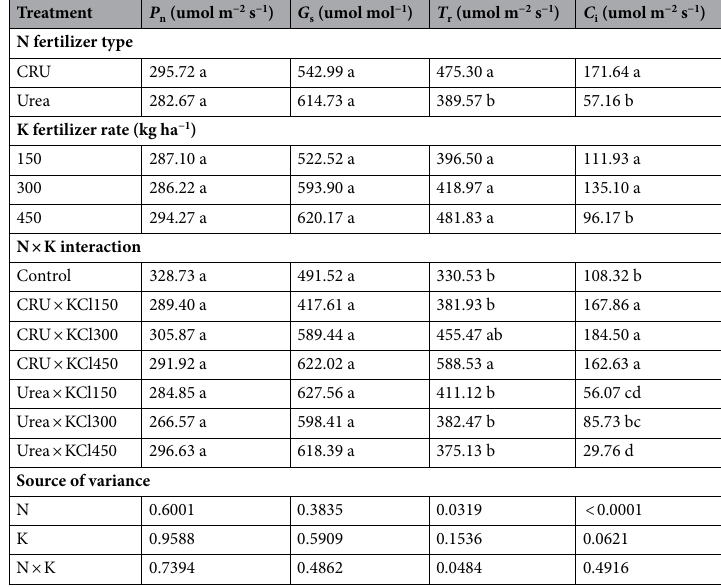
Table 4. The leaf photosynthesis chlorophyll parameters of Italian ryegrass at the second clipping stage. Means followed by different lowercase letters in the same column were significantly different based on analyses with ANOVAs followed by Duncan tests ( P < 0.05). Control no N and K fertilizer, CRU controlled-release urea, KCl potassium chloride, P n photosynthetic parameters including net photosynthetic rate, G s stomatal conductance, C i intercellular carbon dioxide concentration, T r transpiration rate.